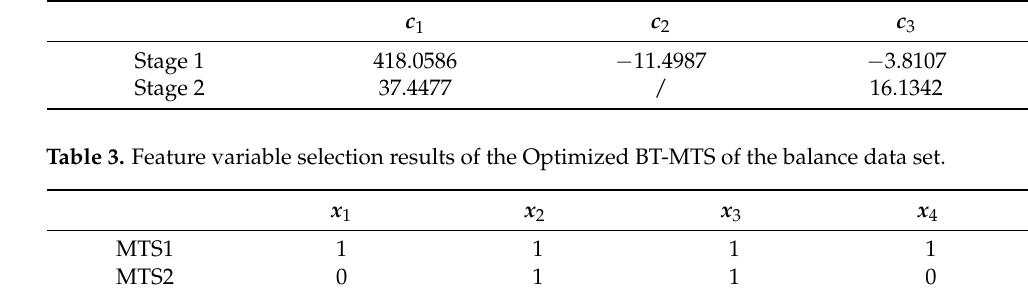
Table 2. Values of fitness function at different stages of balance data set.